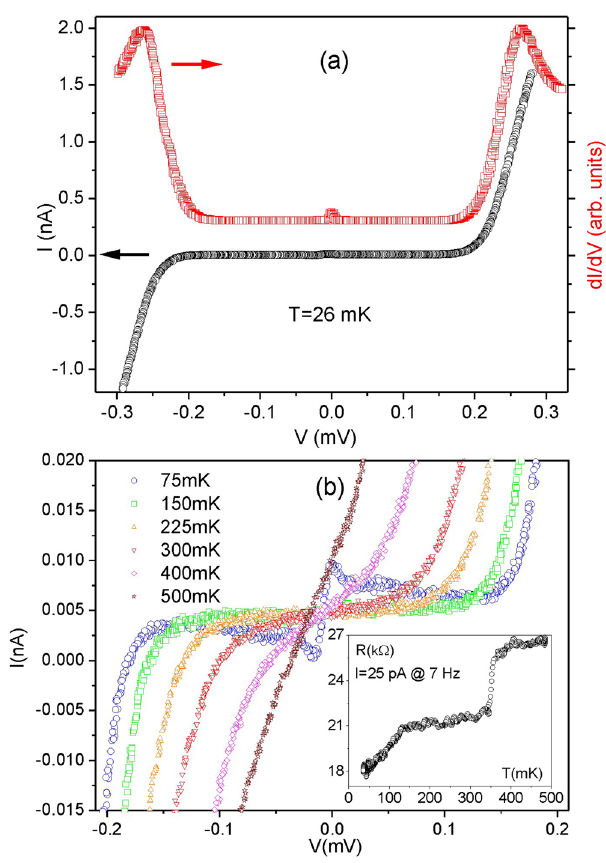
Fig. 5 Current – voltage characteristics and Josephson current. a Current – voltage characteristics for Ti – Al tunnel nanojunction corresponding to the Ti nanowire with L = 20 μ m, d = 35nm, and w = 38nm recorded at T = 26mK. b Zoom of the current versus voltage dependencies taken at various temperatures. At T ≃ 75mK one clearly observes the Josephson current which gradually disappears at higher T . Inset: The total resistance R measured for this nanowire as a function of temperature. Error bars are smaller than data